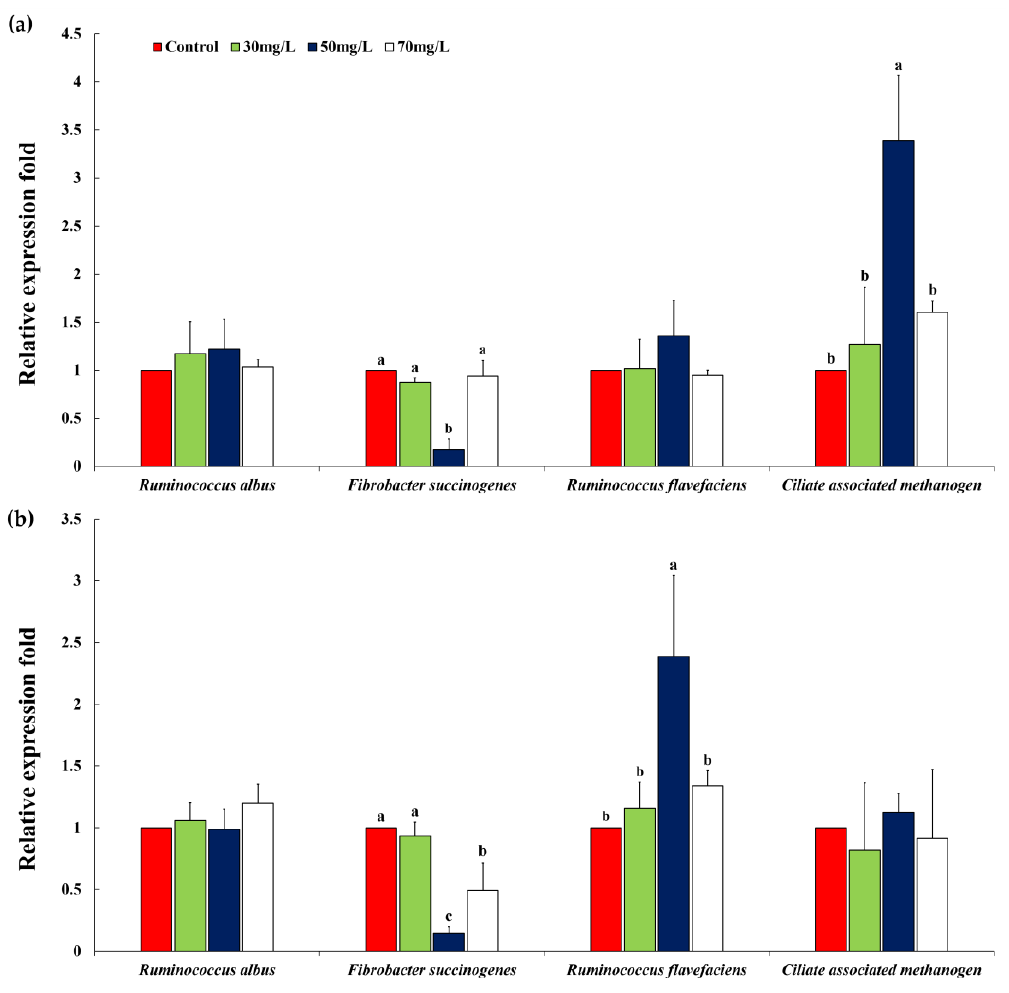
Figure 1. Relative quantification of in vitro rumen microbial population at ( a ) 12 h and ( b ) 24 h of incubation by Pinus densiflora . Error bars indicate the standard error of the mean ( n = 3). a–c Means with different superscript letters in the same row indicate significant differences ( p < 0.05). Animals 2020 , 10 , x FOR PEER REVIEW